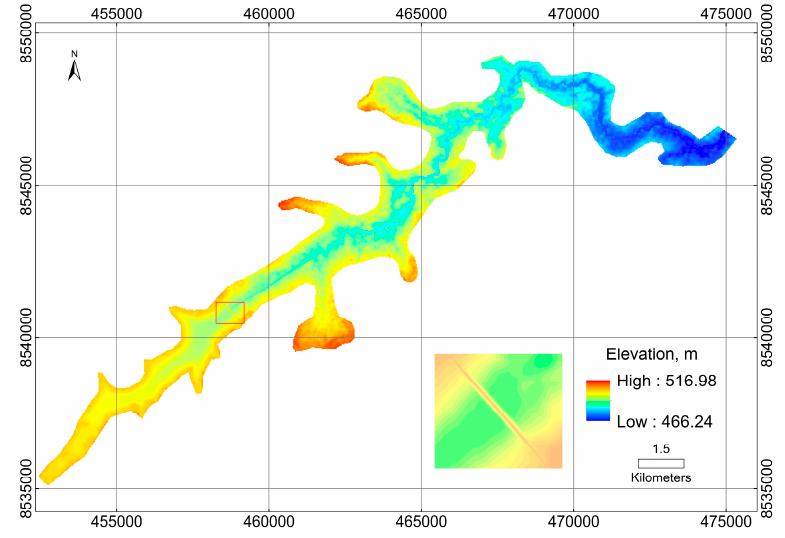
Figure 2. Subset of the SRTM-1s DEM used for the dam-break simulation.